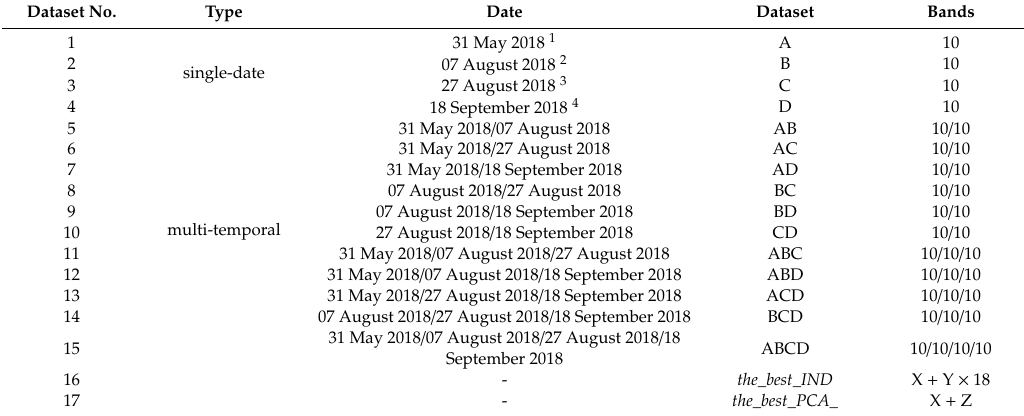
Table 1. Datasets prepared for classification process ( the_best indicates the best-classified dataset assessed using overall accuracy (OA). X—the total number of bands in the best dataset; Y—the number of dates that make up the best dataset; Z—the number of principal component analysis (PCA) bands selected as the most